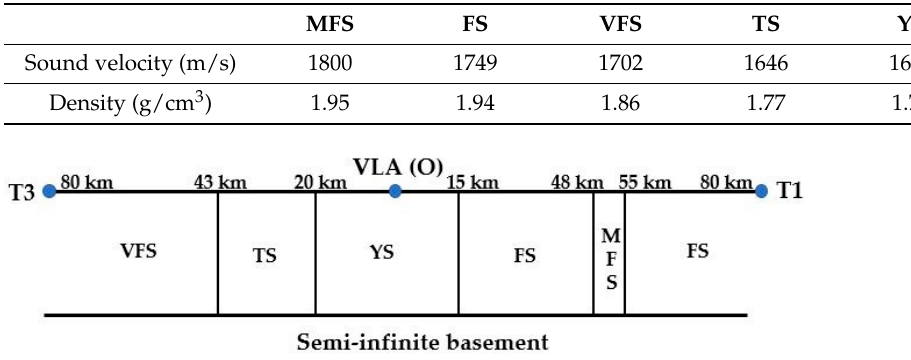
Figure 9. Sediment model in horizontal plane view along two tracks (T1O and T3O).